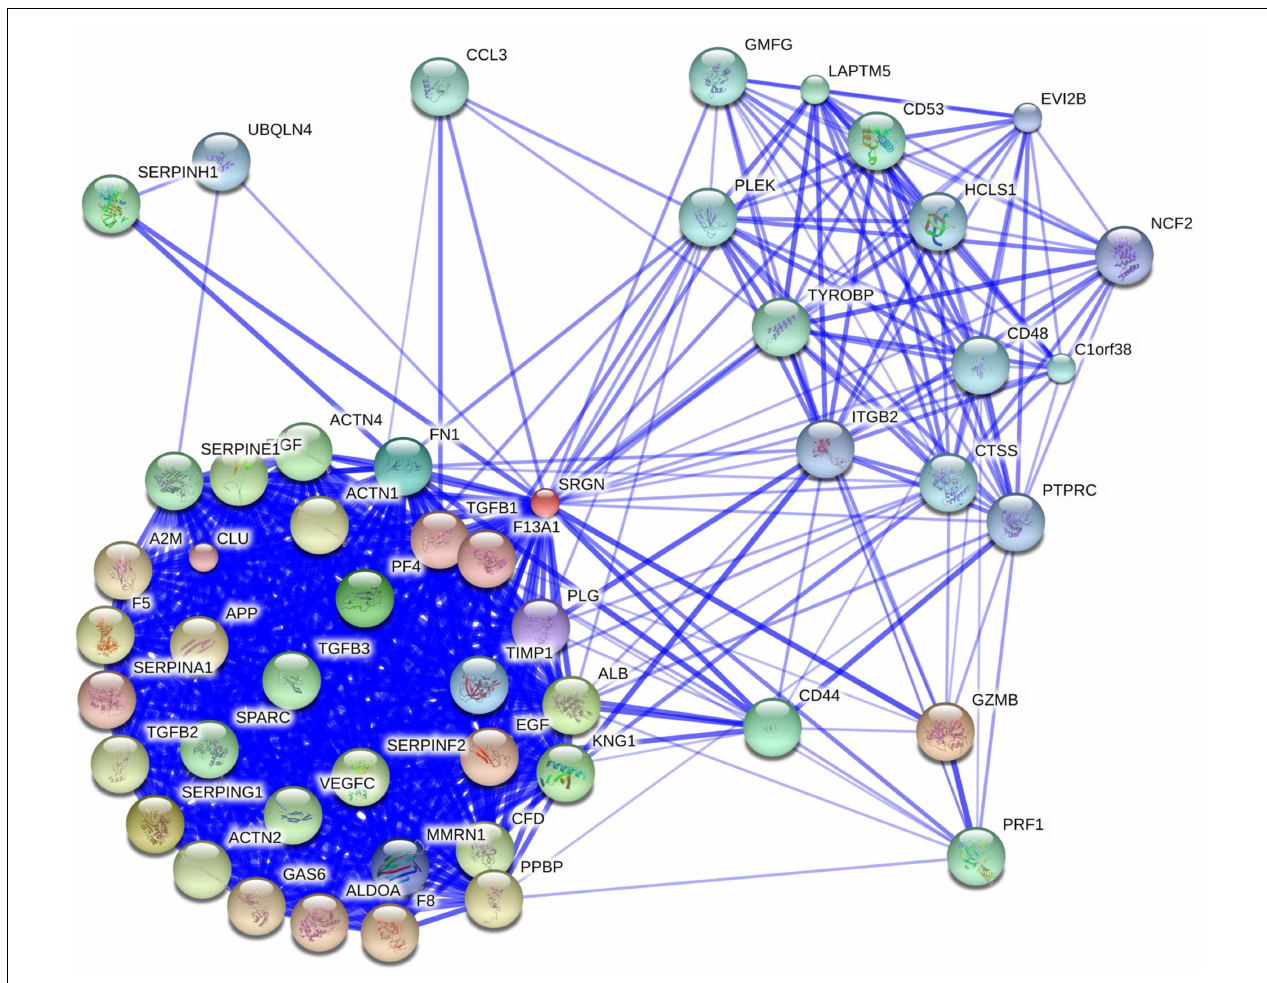
peptidase inhibitor, clade F (SERPINF2), c-fos induced growth factor/vascular endothelial growth factor D (FIGF), vascular endothelial growth factor C (VEGFC), kininogen 1 (KNG1), actinin, alpha 4 (ACTN4), TGFB3, secreted protein, acidic, cysteine-rich/osteonectin (SPARC), serpin peptidase inhibitor, clade E (SERPINE1), serpin peptidase inhibitor, clade H (SERPINH1), PRF1, LAPTM5,TYRO protein tyrosine kinase binding protein (TYROBP), CD53, CCL3, glia maturation factor, gamma (GMFG), pleckstrin (PLEK),THEMIS2/thymocyte-expressed molecule involved in selection protein 2 (C1orf38), cathepsin S (CTSS), CD48, HCLS1; UBQLN4; protein tyrosine phosphatase, receptor type, C (PTPRC), integrin, beta-2